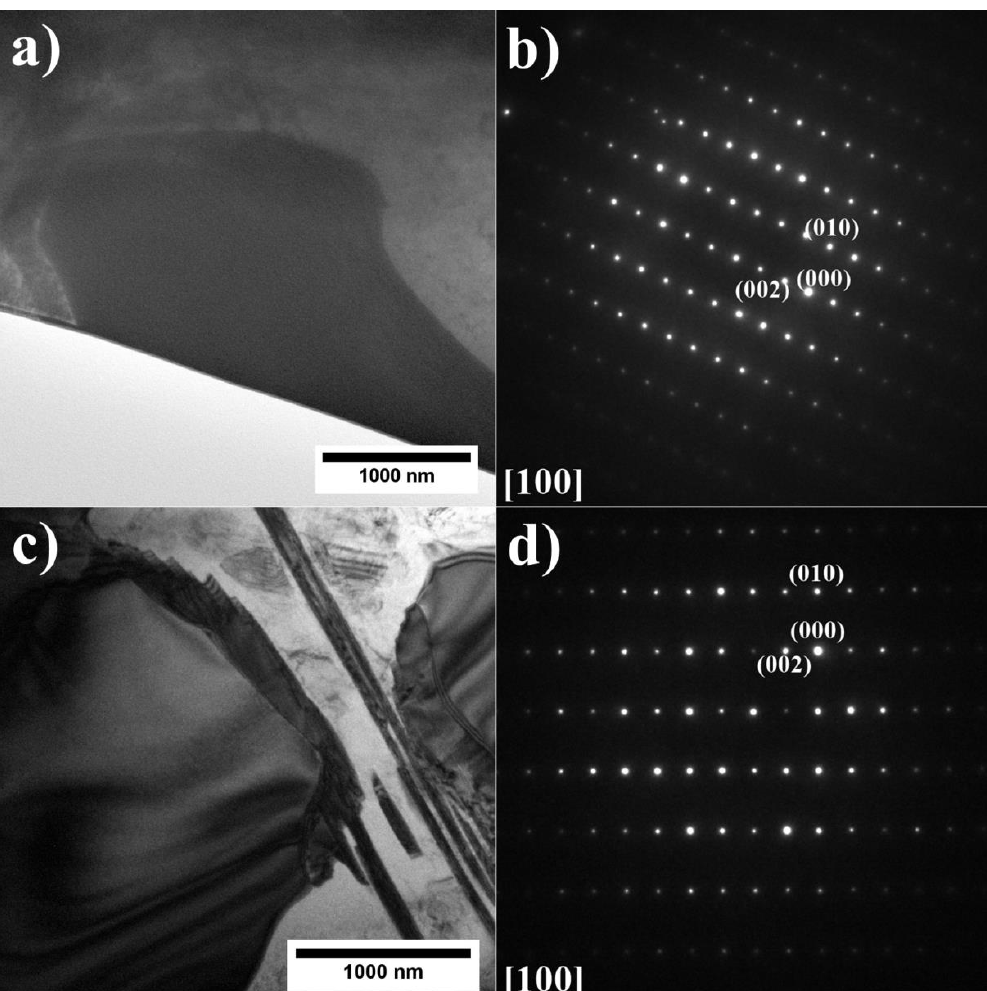
Figure 10. Laves phase precipitates with corresponding SAED patterns: ( a , b ) A3; ( c , d ) A6, TEM-BF.